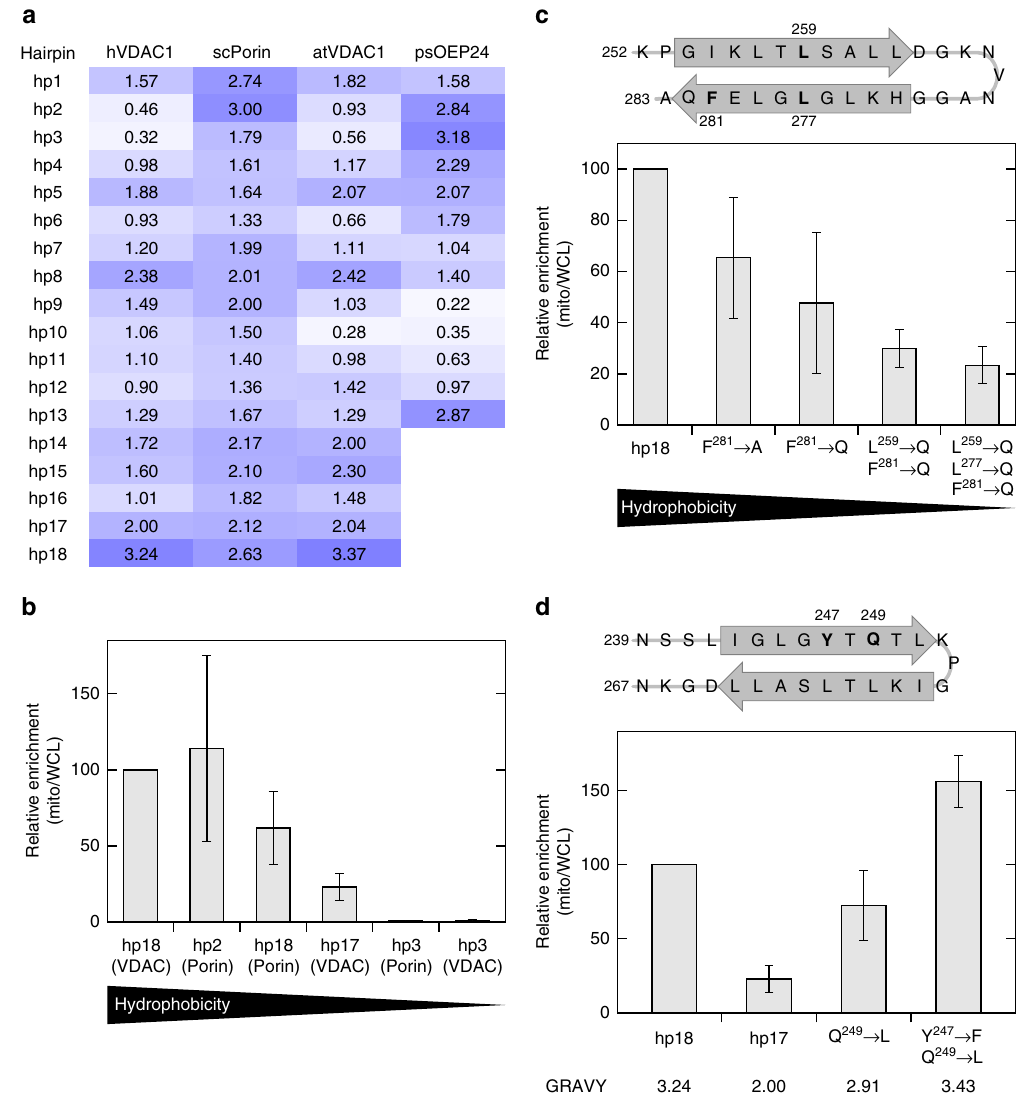
Figure 6 | The hydrophobicity of the b -hairpin motif is important for its mitochondrial targeting efficiency. ( a ) The average hydrophobicity of the hydrophobic face of the b -hairpins of various b -barrel proteins was calculated by summing up the hydropathy values of the residues facing the lipid environment from both b -strands that form each b -hairpin and dividing it by the number of the residues. ( b ) Yeast cells expressing the indicated b -hairpin peptides fused to DHFR were analyzed as in Fig. 2c,d. The mitochondrial enrichment of hp18(VDAC)-DHFR was set to 100. The results represent mean ± s.d. from three independent experiments. ( c ) Top panel: scheme of hp18(VDAC) used in these experiments. Grey arrows indicate the residues that form a b -strand in full-length hVDAC1. Residue numbers correspond to the numbering of full-length hVDAC1. Amino acids that were mutated are shown in bold font. Bottom panel: yeast cells expressing hp18(VDAC) peptide or its variants with the indicated mutations fused to DHFR were analyzed as in Fig. 2c,d. The mitochondrial enrichment of the control hp18-DHFR was set to 100. The results represent mean ± s.d. from three independent experiments. ( d ) Top panel: scheme of hp17(VDAC) depicted as in (c). Bottom panel: yeast cells expressing DHFR fused to hp18(VDAC) peptide, hp17(VDAC) peptide or variants of hp17(VDAC) with the indicated mutations were analyzed as in Fig. 2c,d. The mitochondrial enrichment of the hp18-DHFR protein was set to 100. The results represent mean ± s.d. from three independent experiments. GRAVY, grand average hydrophobicity of the hydrophobic face of the